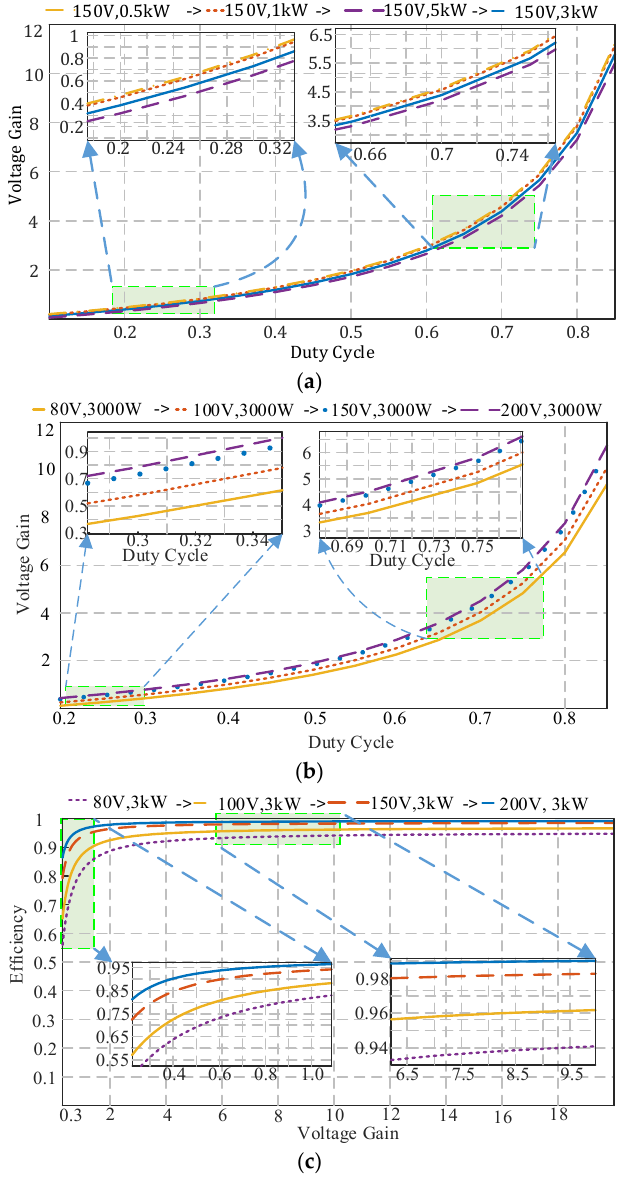
Figure 9. Different cases of study for the proposed converter: ( a ) Voltage gain at different duty cycle and different loading. ( b ) Voltage gain with fixed loading and different input voltages. ( c ) Converter efficiency at different input voltages.